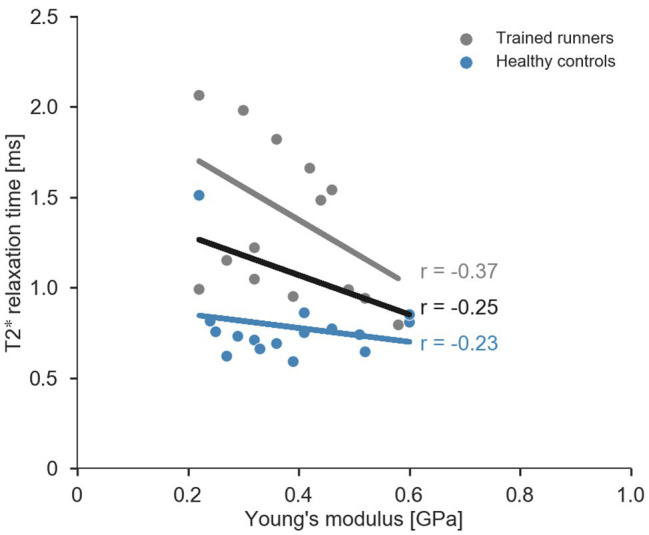
Scatterplot and regression lines (combined data: black, trained runners: grey, and healthy controls: blue) for relationship between average T2* relaxation time and Young’s modulus of the free Achilles tendon.